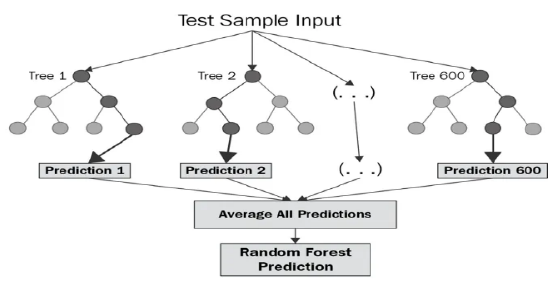
Fig. 1. Random Forest